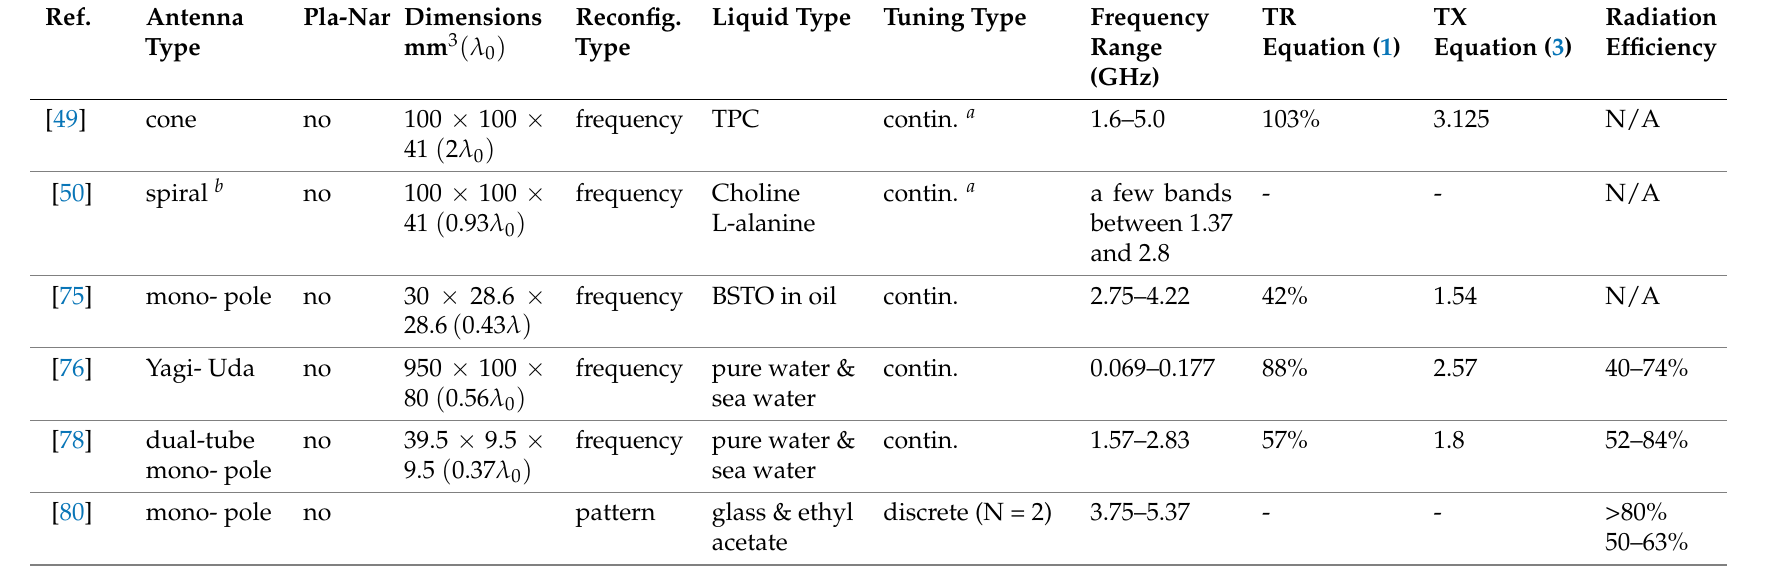
Table 4. Liquid Variations, Liquid Solutions and Other